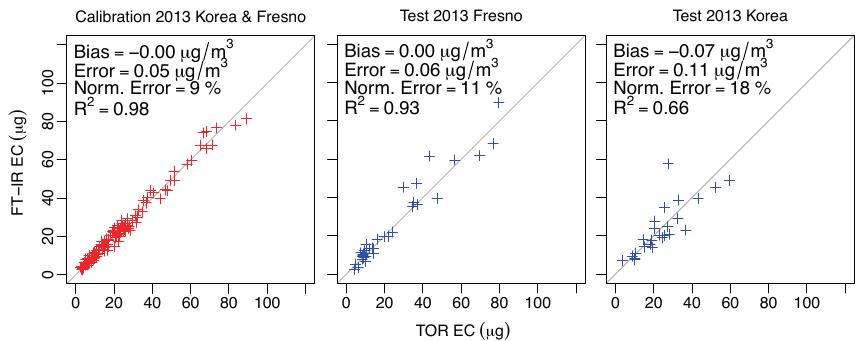
Figure 13. Scatter plot and performance metrics between FT-IR EC and TOR EC of the Korea and Fresno sites (site ID 10 and 11 respec- tively). A new calibration set, based on two-thirds of the ambient samples collected at these two sites in 2013 is used for a dedicated model. Concentration units of µgm − 3 for bias and error are based on the IMPROVE nominal volume of 32.8m 3